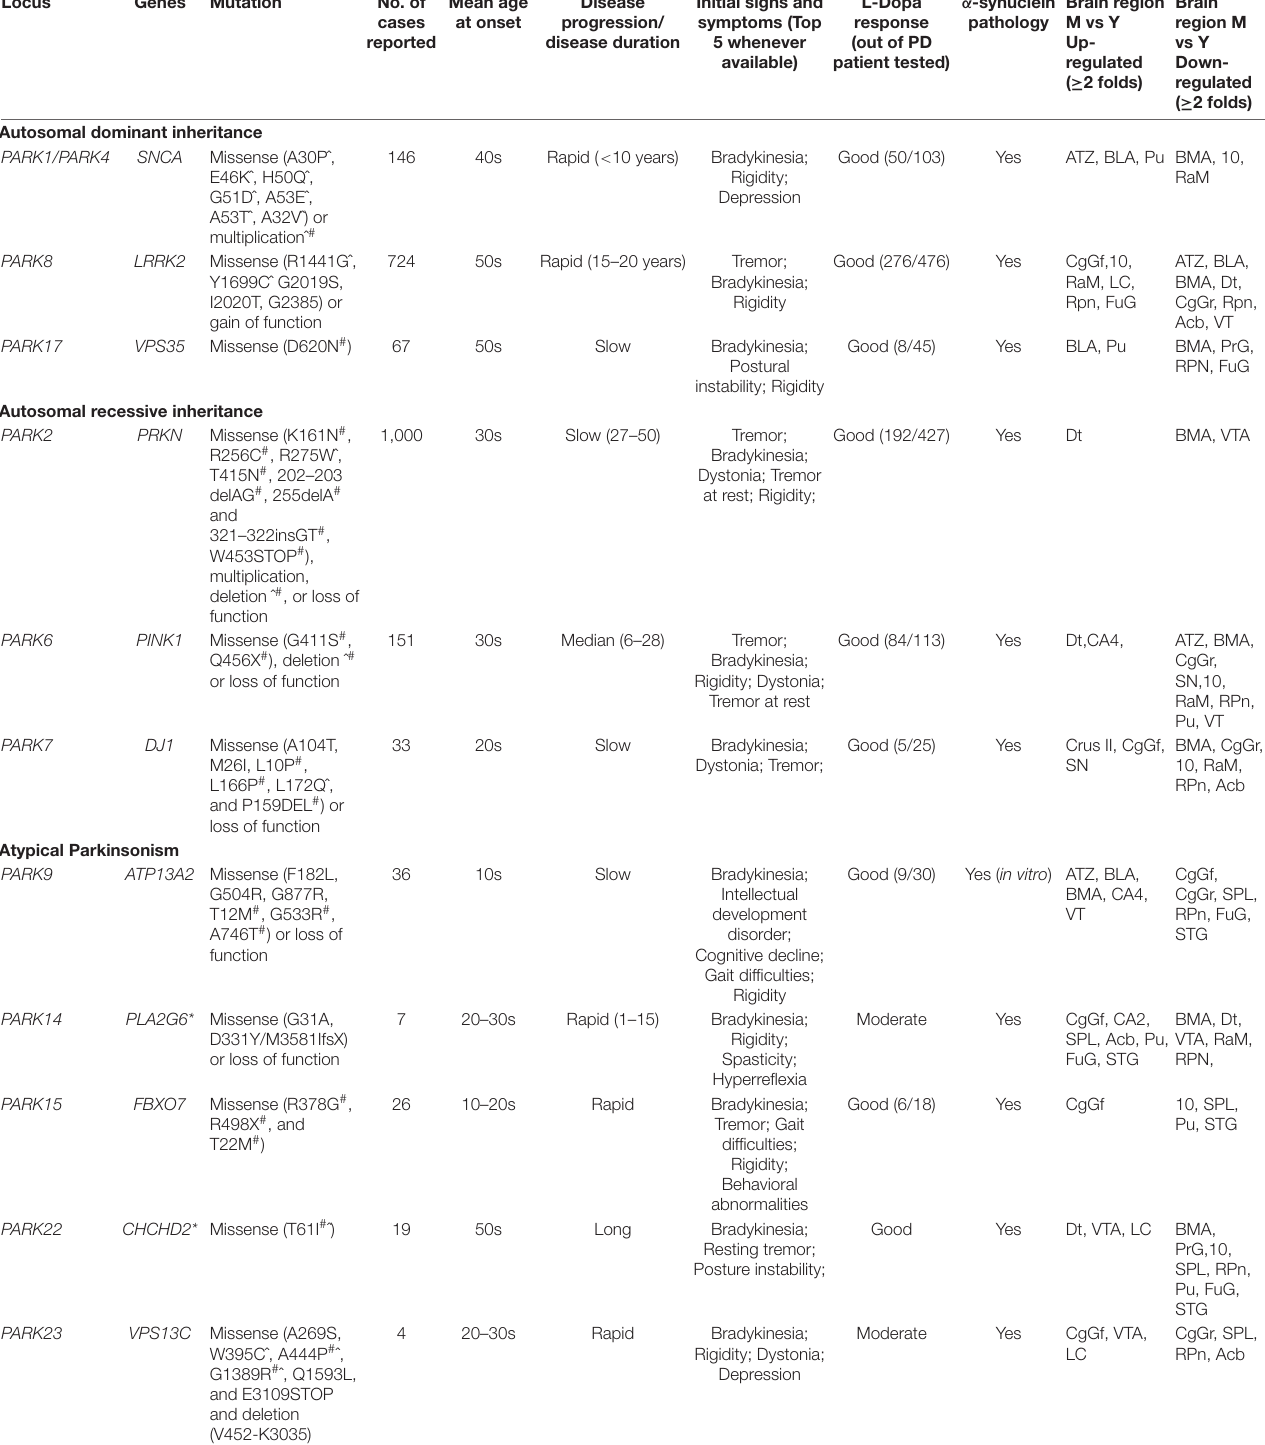
TABLE 1 | PARK genes that are linked with mitochondrial function.